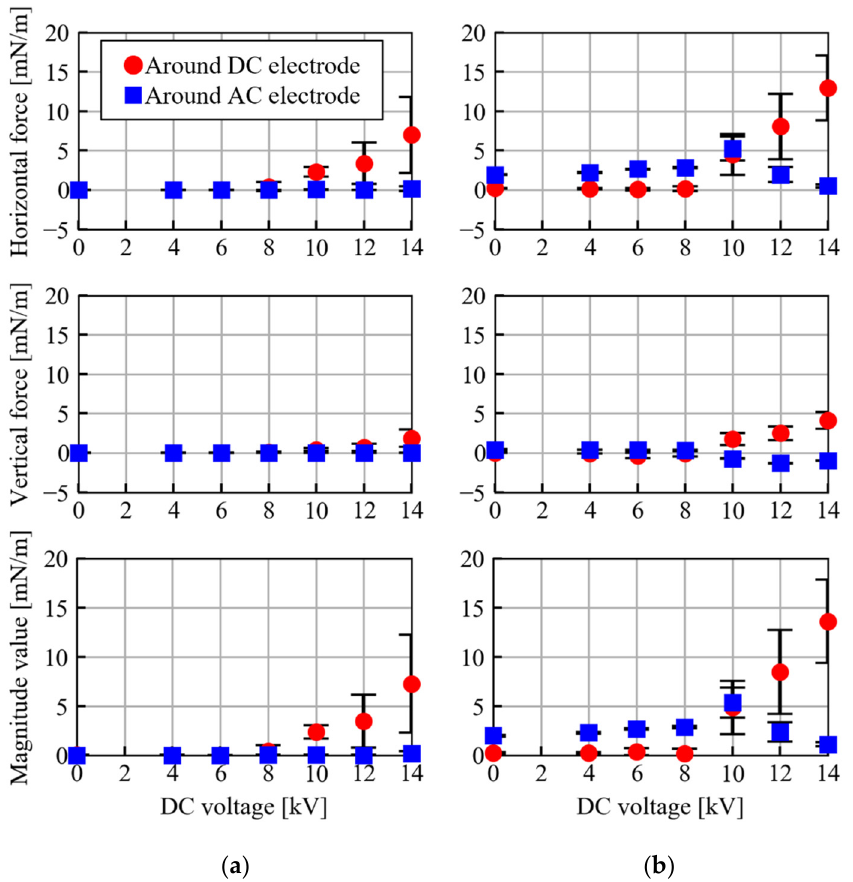
Figure 16. Momentum flow rate versus the DC voltage when the AC voltage was 10 kV pp at 4 kHz in the ( a ) CD-PA and ( b ) TED-PA.